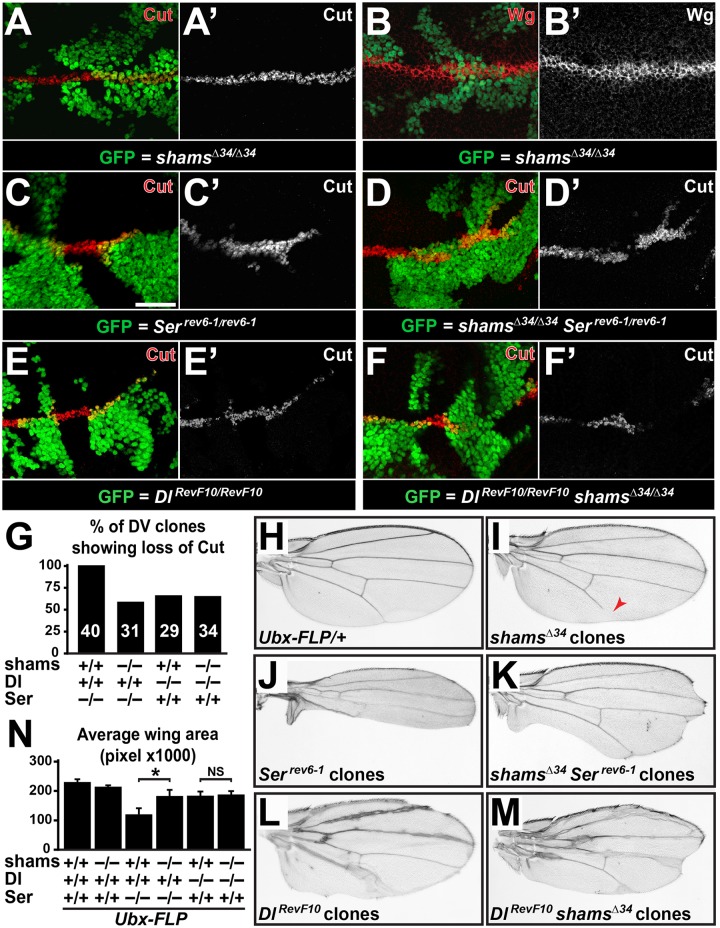
Simultaneous loss of shams partially rescues Notch signaling in Serrate clones spanning the DV boundary, where Delta is the only ligand.(A-N) All animals raised at 25°C. (A-F’) Third instar wing imaginal discs with mutant cells marked by the presence of GFP. Scale bar in (C) is 25 μm and applies to A-F’. Dorsal is up, anterior to the left. (A-B’) shamsΔ34 mutant clones do not seem to show altered Cut (A-A’) and Wingless (Wg) (B,B’) expression domains at the developing wing margin except a slight broadening in clone area compared to wild-type. (C,C’) Serrev6-1 mutant clones lack Cut expression (red) except for cells directly adjacent to wild-type cells (number of clones n = 40). (D,D’) shamsΔ34
Serrev6-1 double-mutant clones often express Cut in cells at the clonal boundary and within the mutant clones (number of clones n = 31). (E-F’) Comparable lack of Cut expression in DlRevF10 mutant clones (E,E’; number of clones n = 29) and DlRevF10
shamsΔ34 double mutant clones (F,F’; number of clone n = 34). (G) Graph represents % of mutant clones crossing the DV boundary which show loss of Cut expression in indicated genotypes. Number of clones scored for each genotype is shown. (H-M) Adult wings harboring the indicated single or double-mutant clones generated by the Ubx-FLP transgene. Clones are not marked. (N) Graph represents average wing area (n = 13 for each genotype) in the indicated genotypes. Error bars are standard error of mean. *P<0.05, NS: not significant.